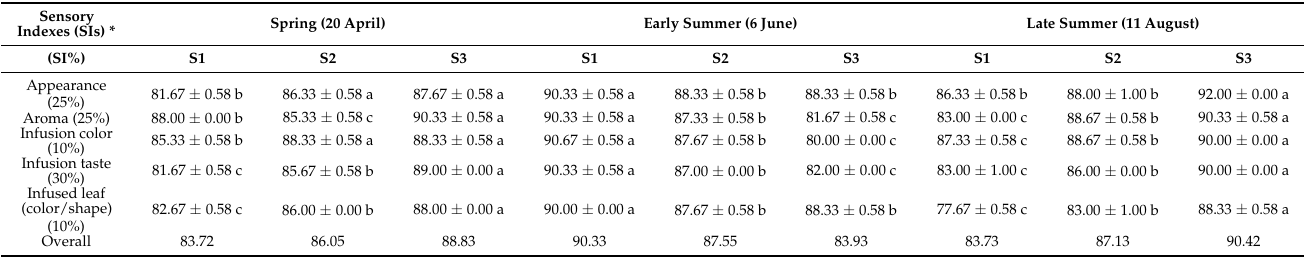
Table 2. Scores in sensory evaluation of green teas based on different treatments in spring and early and late summer. Sensory